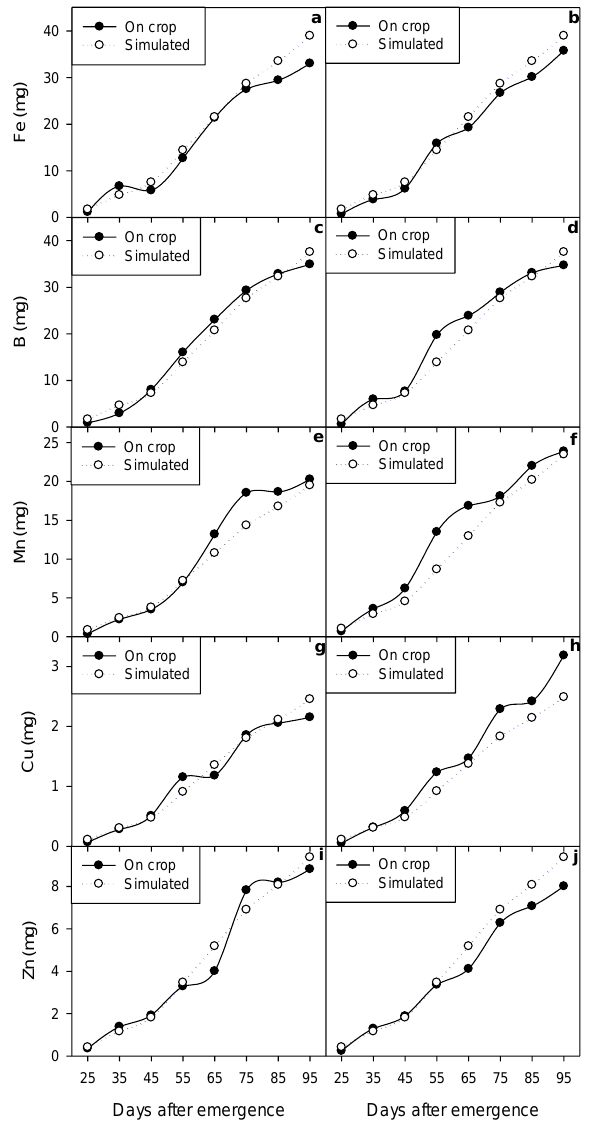
Figure 5. Comparison between the real and dynamically simulated data for micronutrient accumulation in the Vitaly ( a , c , e , g , i ) and Luxell ( b , d , f , h , j ) cucumber plant varieties. The data corresponding to the culture cycle used for the calibration are presented. The real data are the average of four replicates.